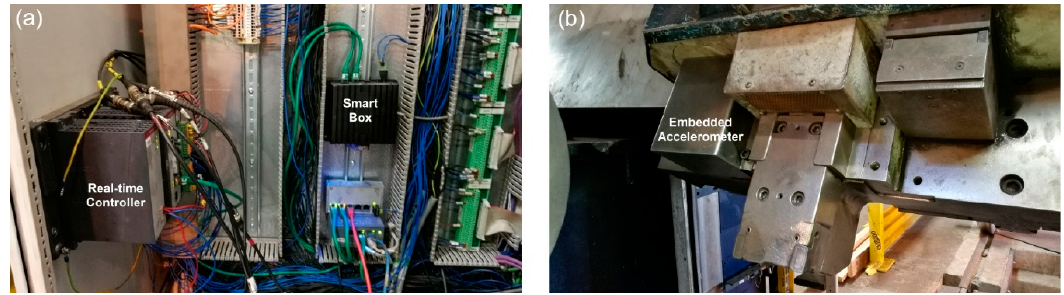
Figure 10. Installed hardware: ( a ) real-time controller, IoT monitoring hub, and ( b ) triaxial Figure10. Installedhardware: ( a )real-timecontroller, IoTmonitoringhub, and( b accelerometer.